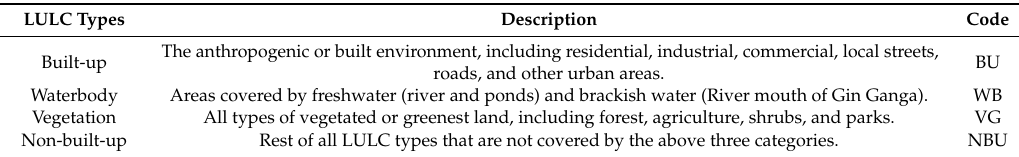
Table 1. Description of land use land cover (LULC) types and their